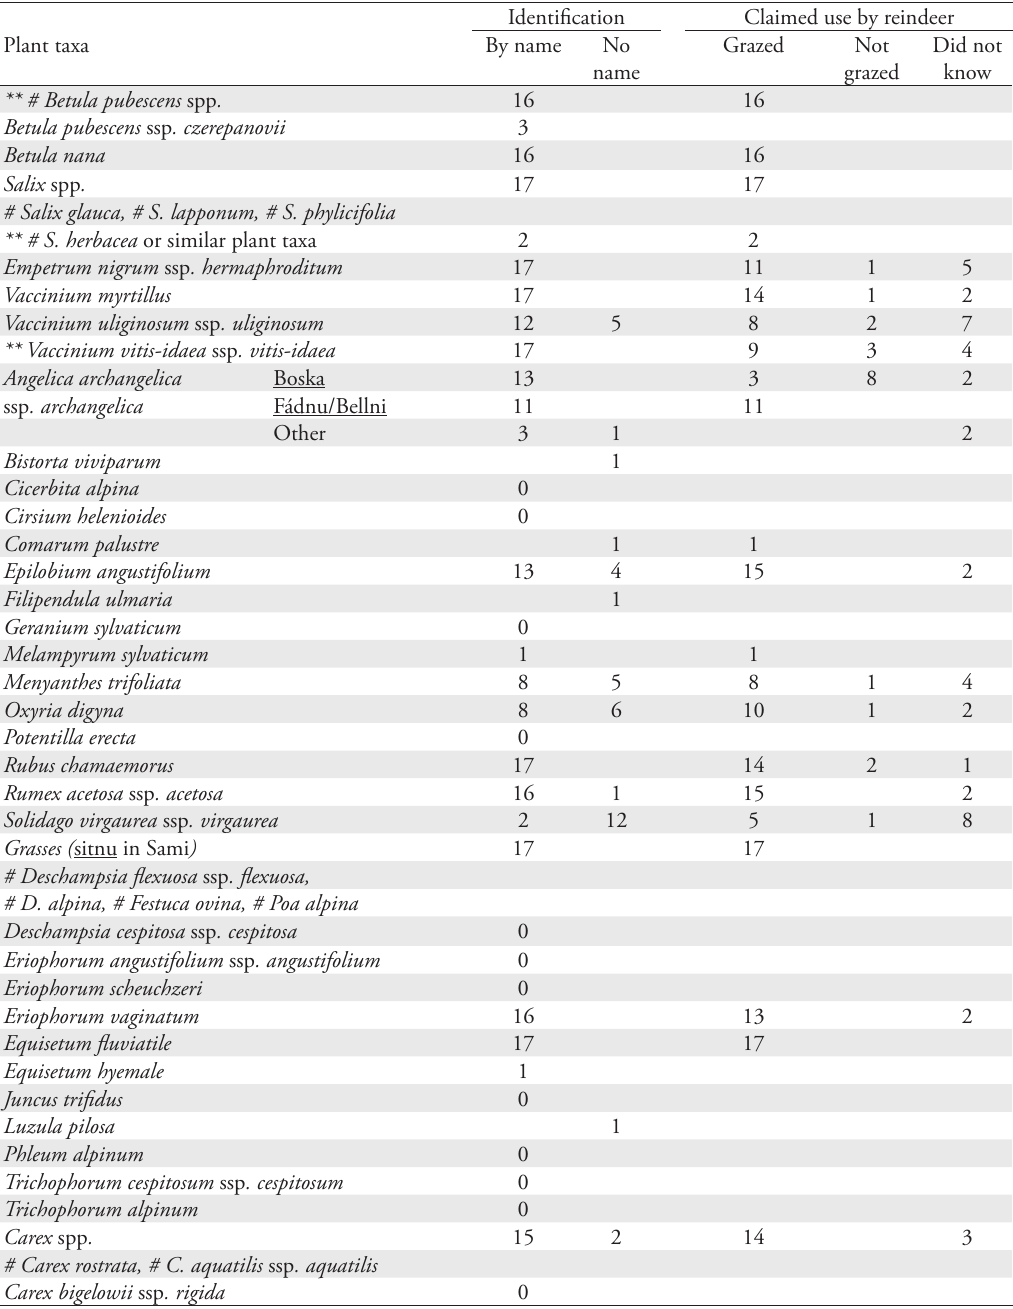
Table 2 . Summary of responses about 29 plant taxa and 40 species presented to 17 informants as close-up pictures (photos and drawings) and two additional species introduced by the informants. The taxonomy follows Mossberg & Stenberg (2003). # is collective name or identification; ** means no picture was shown; underlined name means Sami